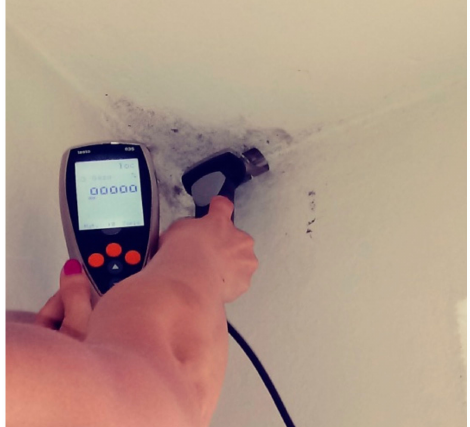
Figure 14. Analyzed corner. Measurement of surface humidity with the Testo 635-2